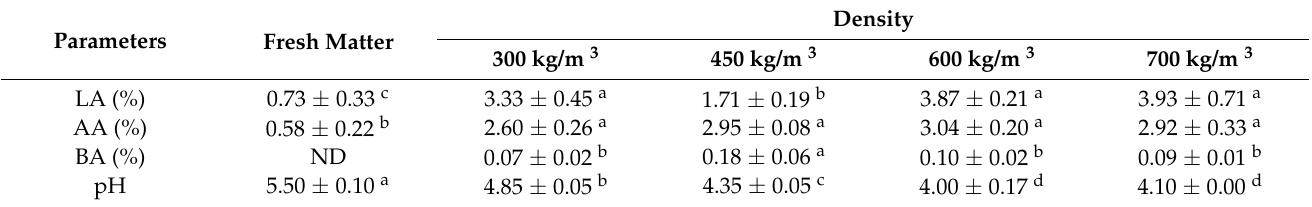
Table 4. Fermentation quality of whole-plant corn silage under different compaction